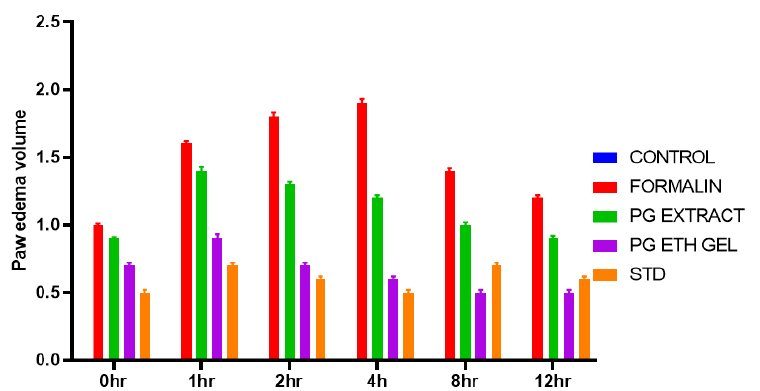
Figure 9. Visual observation of rat during the study of oedema: ( A ) control, ( B ) formalin-induced oedema, ( C ) ethosome suspension, ( D ) gel, and (E) standard. Arrow indicates the oedema of each group of rats on the left hind paw.